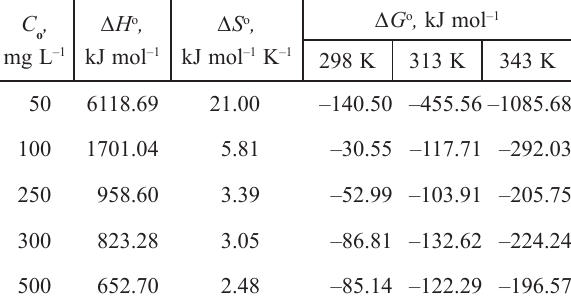
Table 5 – Values of the thermodynamic parameters of vita- min E adsorption on zeolite C , o mg L